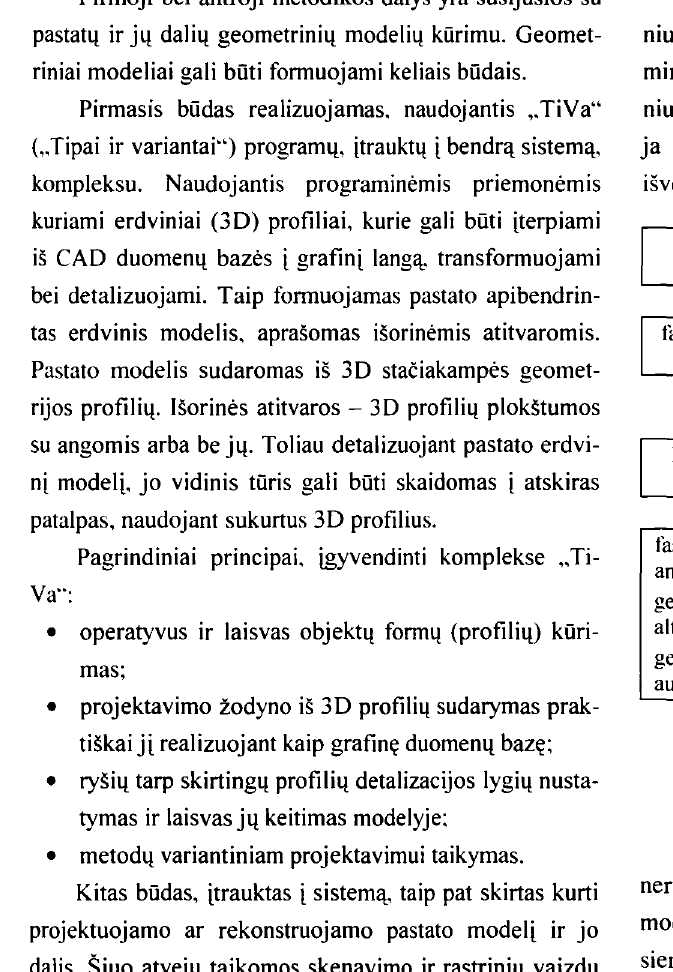
Fig 2. The structure of the building model data tile Remiantis skaitini4 duomen4 failu automatiskai ge neruojamas ir vizualizuojamas scheminis erdvinis pastato modelis. Erdvinio pastato modelio pavirsiai: isorines